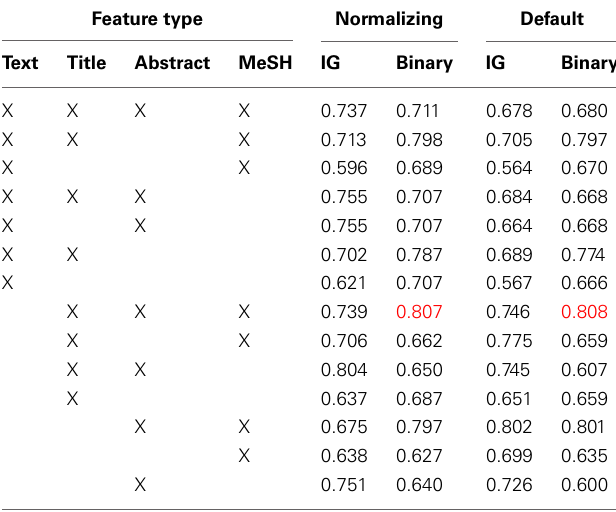
Table 3 | Summary of area under the ROC curve (AUC) results observed in the baseline classifier cross-validation (five repetitions of two-way; 5 × 2)